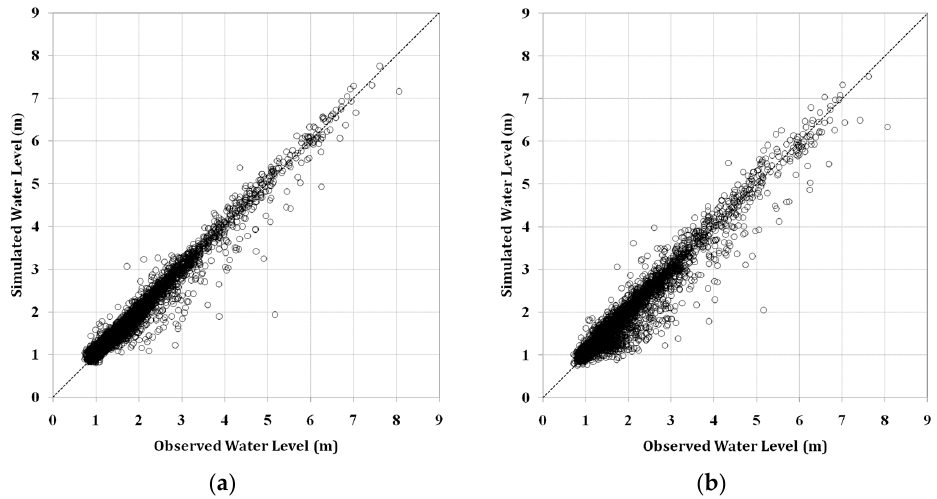
Figure 13. Scatter plots of observed and forecasted water levels with a lead-time of 2 h. ( a ) ANN2d; ( b ) ANN2a.